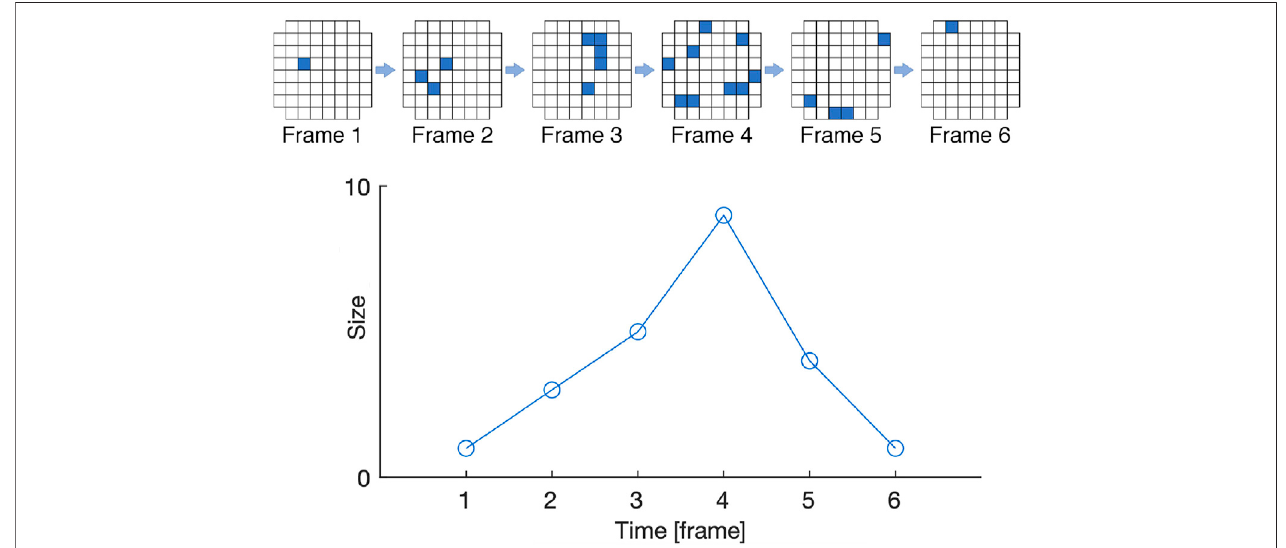
FIGURE 2 | Graphical representation of avalanches in a system composed by 60 cells arranged in a grid. The top row shows an initial activity from a single cell at Frame 1 that propagates to three cells at Frame 2, eventually ending at Frame 6. The bottom row shows the avalanche size and duration. Image adapted from (Heiney et al., 2021) in the context of biological neural networks on Micro-Electrode